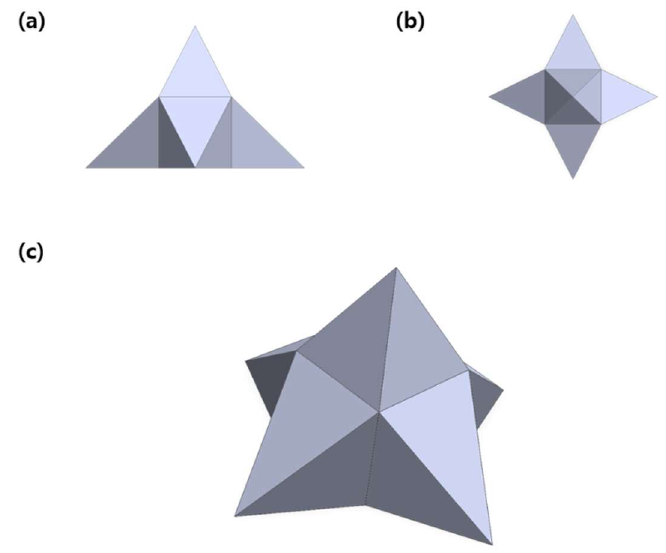
Figure 1. 3D Computer-aided design (CAD) images of the designed MLP displaying the ( a ) side view, ( b ) top view, ( c ) and overall view. Each MLP had a height of 300 μm, a base length of 450 μm, a needle length of 150 μm, and a tip diameter of 30 μm.